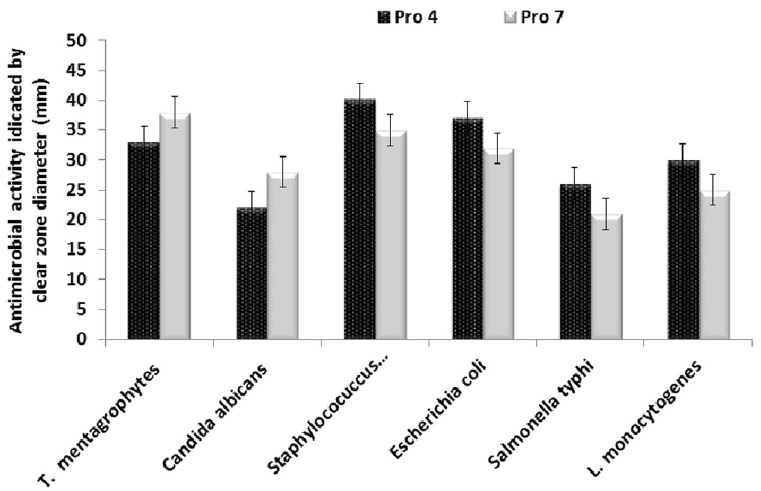
Figure 2. Antimicrobial activity of partial purified bacteriocin of selected probiotic isolates against different food-borne pathogen and Dermatophytes microorganisms indicated by clear zone diameter (mm) a,b . a Each value represents mean of sample ± SD for n = 3. b Diameter of inhibition zone was measured as the clear area centered on the agar well containing the